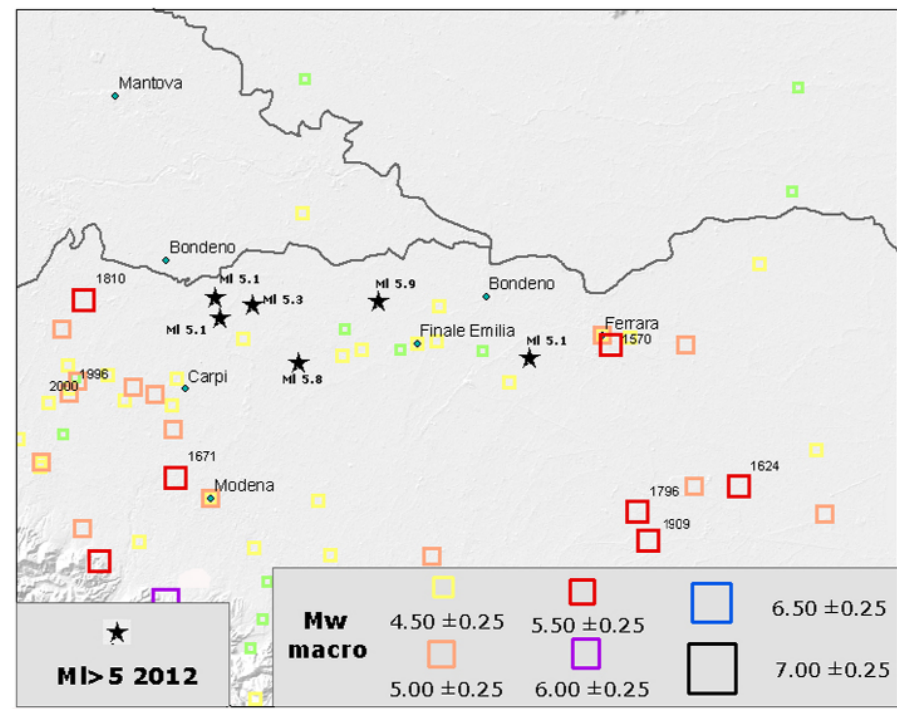
Figure 1. Seismicity of the studied area, according to Rovida et al.